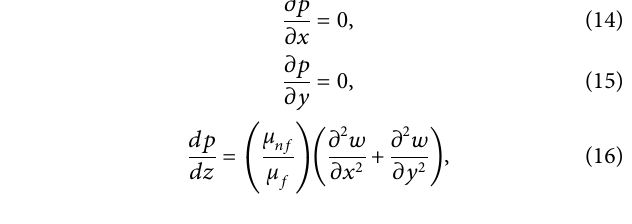
Frontiers in Physics |